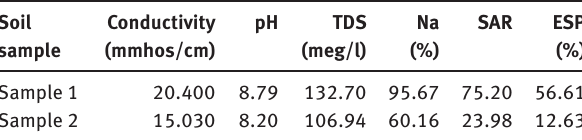
Table 2: Chemical compositions of the